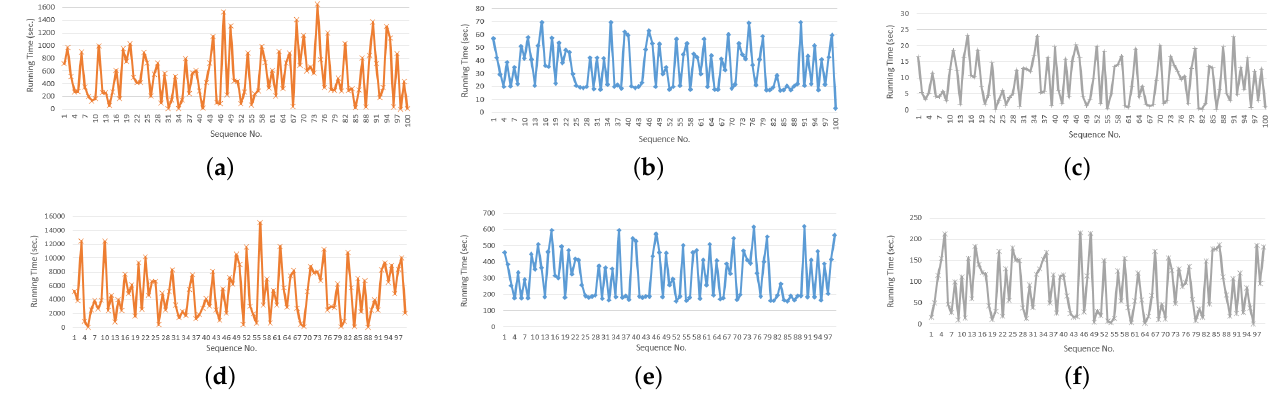
Figure 11. Execution time of proposed parallel approaches with Genome dataset and varying lengths of query strings. ( a ) Inter-Task parallelism with query sequence gbpln103. ( b ) Intra-Task parallelism with query sequence gbpln103. ( c ) Hybrid parallelism with query sequence gbpln103. ( d ) Inter-Task parallelism with query sequence gbgss201. ( e ) Intra-Task parallelism with query sequence gbgss201. ( f ) Hybrid parallelism with query sequence